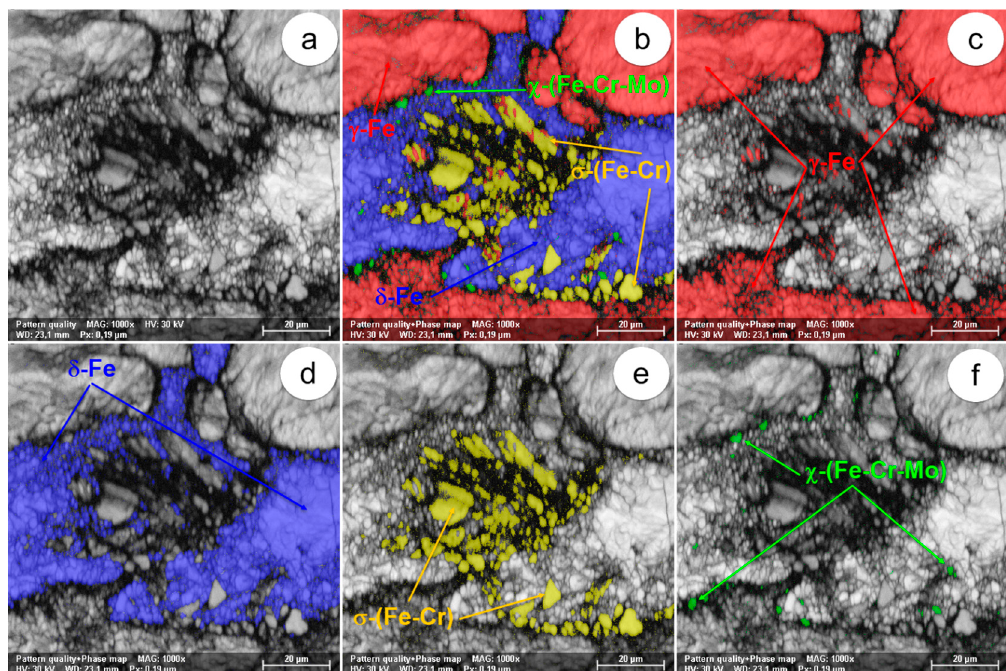
Figure 7. The SEM-EBSD composite images ( × 1000) obtained after forging at 850 ◦ C: ( a ) microstructure of the analysed field; ( b ) the distribution of existing phases in the microstructure of the analysed field; ( c ) the distribution of the γ -Fe phase; ( d ) the distribution of the δ -Fe phase; ( e ) the distribution of the σ -(Fe-Cr) phase; ( f ) the distribution of the χ -(Fe-Cr-Mo) phase.